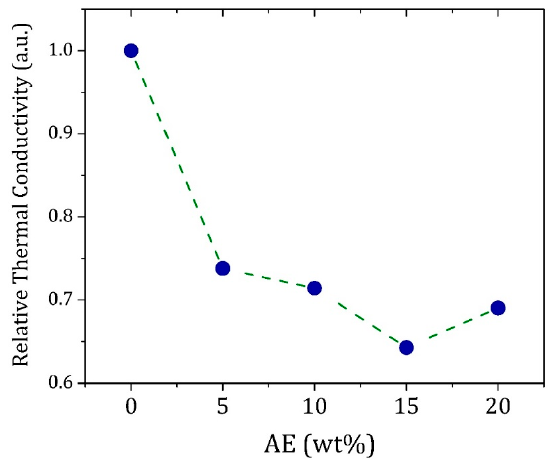
Figure 8. Relative thermal conductivity of the PC and PC / AE composites with 28 d of curing.